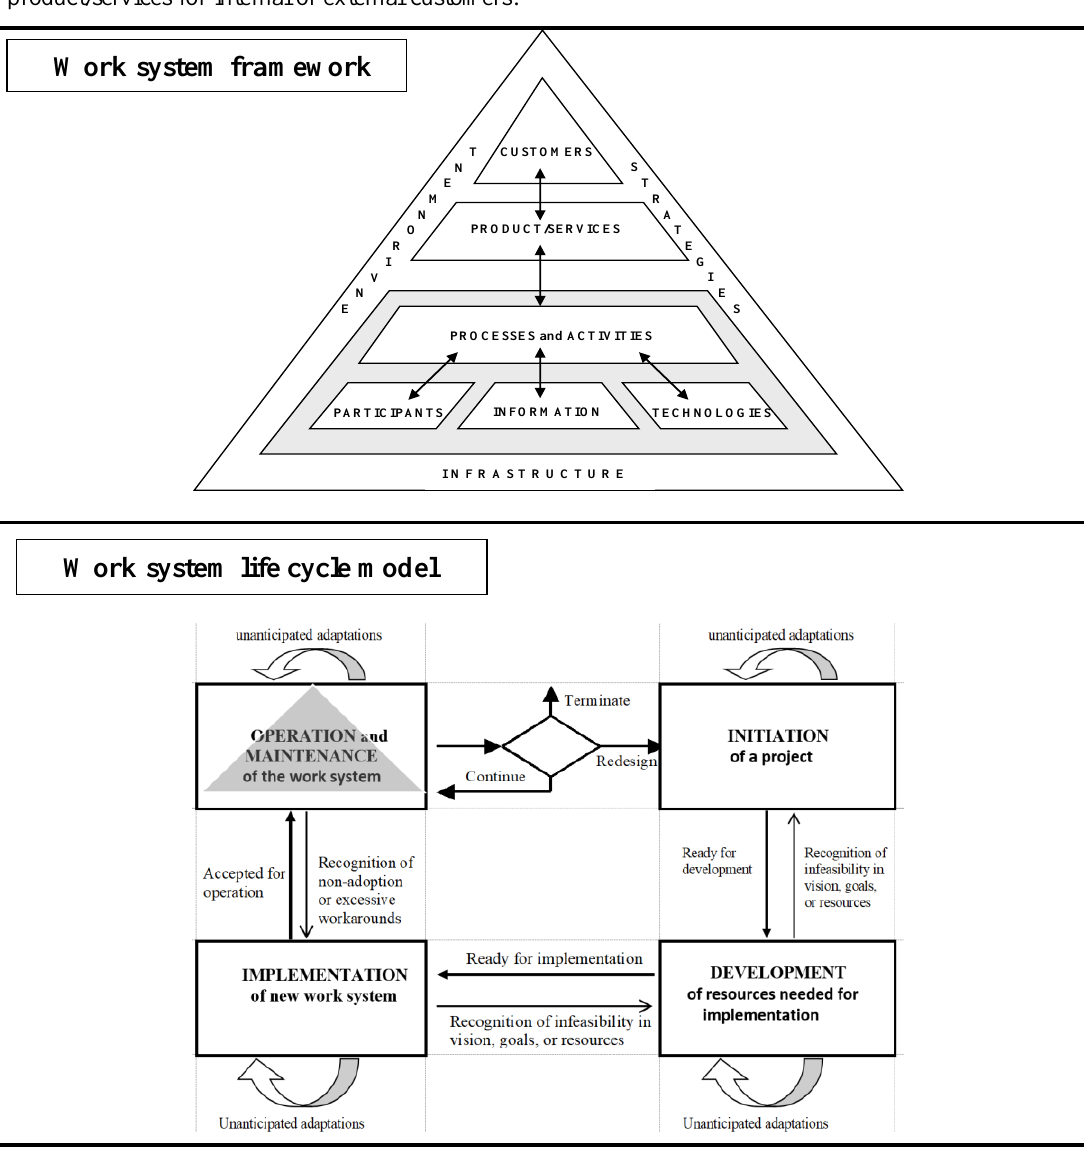
Figure 1. Three parts of work system theory: 1) the definition of work system, 2) the work